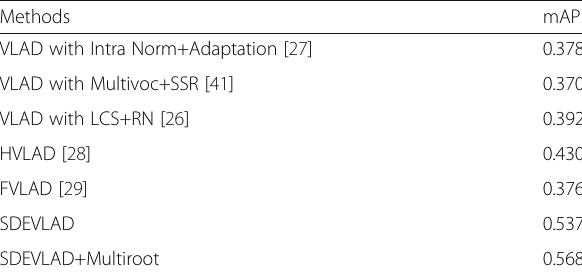
Table 4 Comparison of 128-dimensional results in large-scale image retrieval on Holidays with Flickr1M